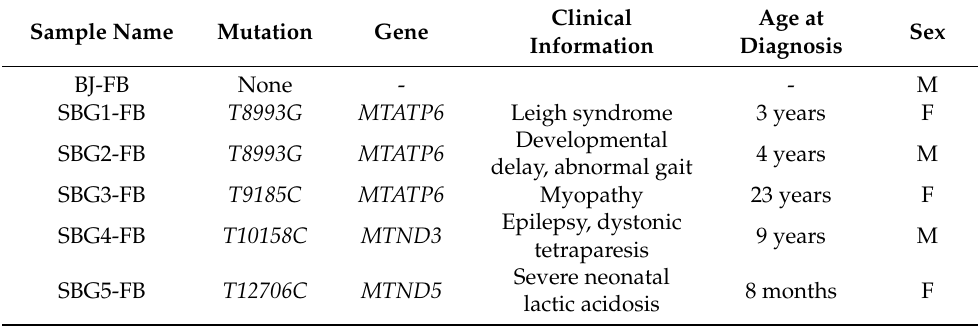
Table 1. Clinical information of five patient fibroblast cell lines with pathogenic mtDNA muta- tions [31,32] and CTL control cell line.